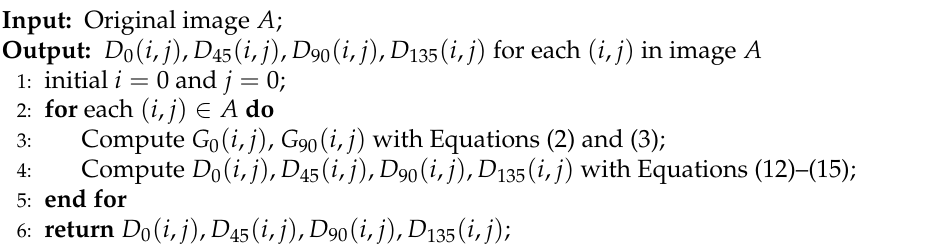
Algorithm 1 Projection of each